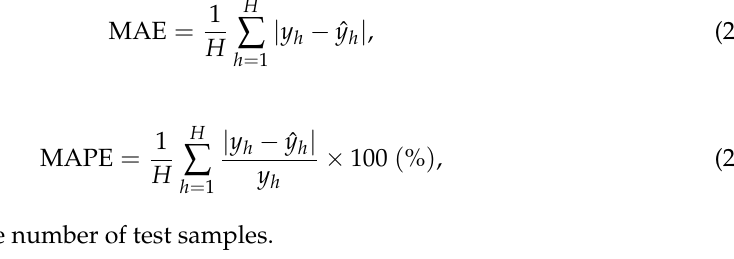
Table 2. Comparative methods used in the